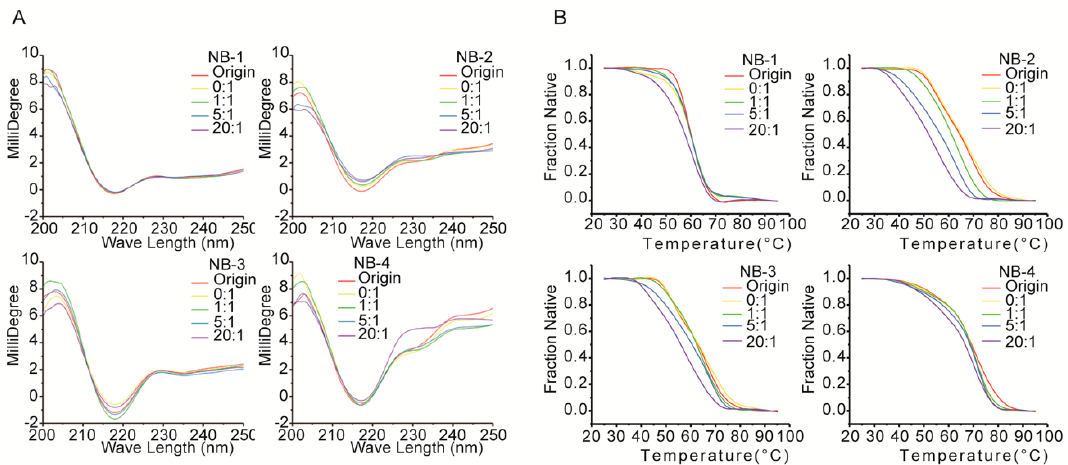
Figure 5. Spectra scanning ( A ) and thermal denaturation ( B ) of VHHs measured by CD. Five samples were taken for each VHH. The group “origin” represented original sample that without any treatment, the others groups represented the samples modified with corresponding molar ratio of NHS-Fluo. The spectrum signals at 216 nm were exported for thermal denaturation analysis. Table 3. Midpoints of the denature profiles of the modified VHHs.